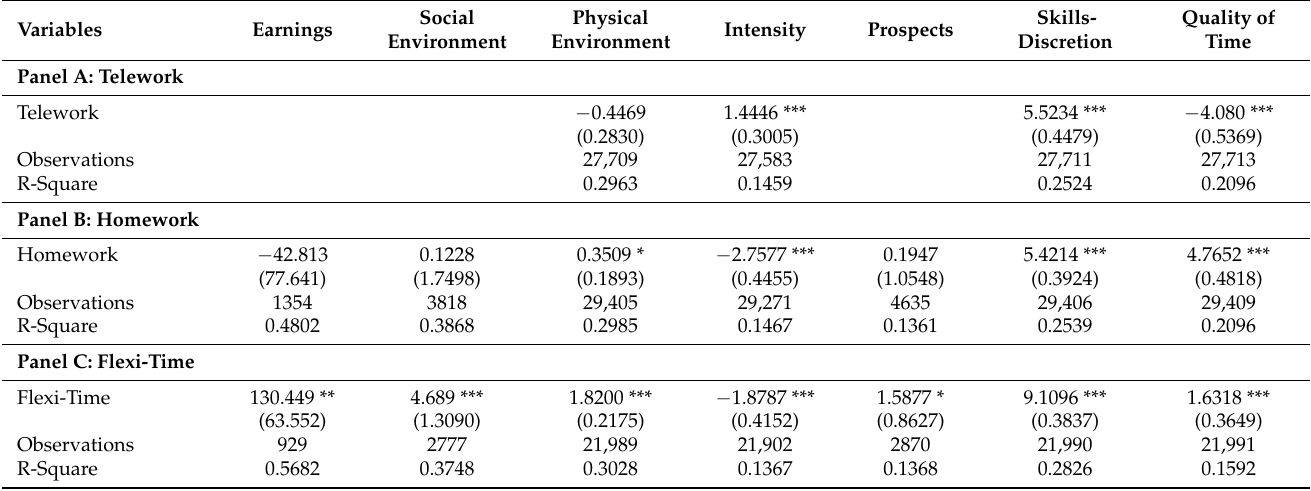
Table 6. Flexible Employment Schemes and Job Quality for Workers with Disabilities and Health Problems.